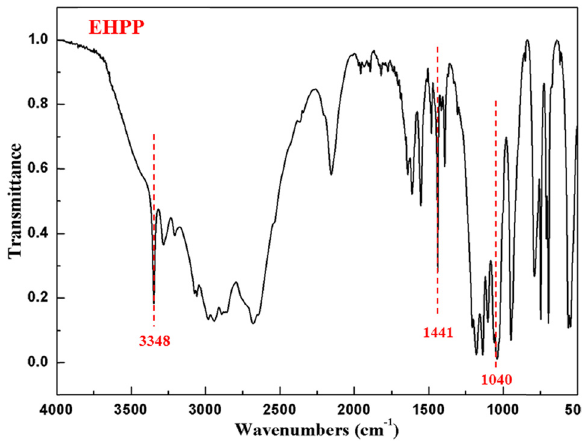
Figure 2: FTIR spectra of